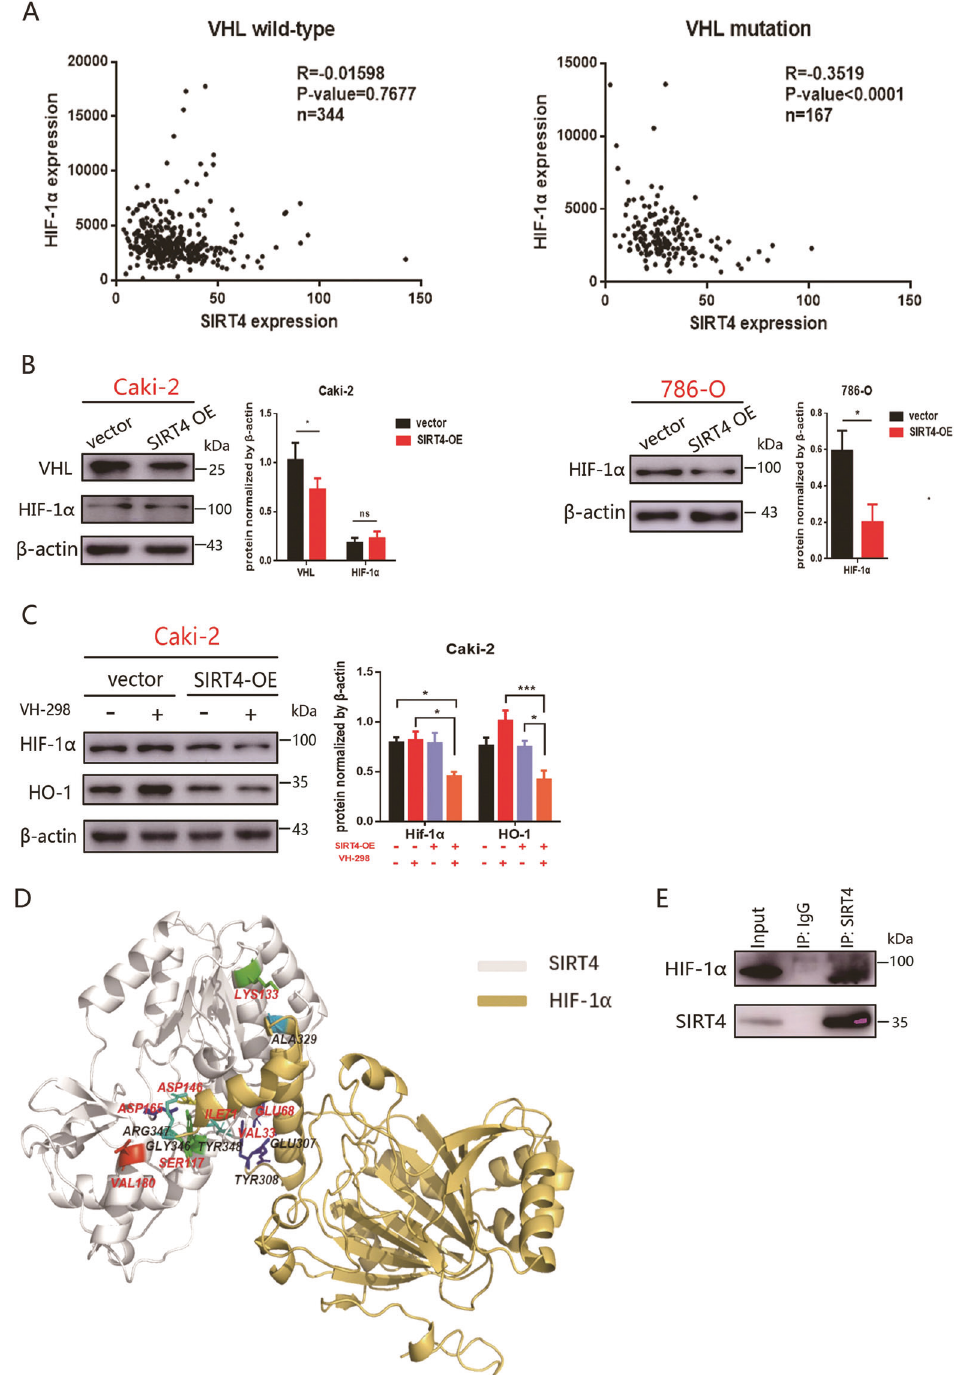
Fig. 6 SIRT4 interacts with HIF-1 α and directly suppresses the expression of HIF-1 α . A Analyzed the correlation between HIF-1 α and SIRT4 in mutated VHL and nonmutated VHL group from a TCGA cohort of ccRCC patients. B HIF-1 α protein in SIRT4 overexpressed 786-O and Caki-2 cells were displayed by western blot. The quanti fi cation analysis is shown on the right panel. C Caki-2 cells were treated with VHL inhibitor, VH-298 (50 µM), for 24 h followed by western blot. Densitometric analyses of HIF-1 α /HO-1 are shown on the right panel. D Molecular docking of SIRT4 and HIF-1 α was realized by zdock. E The immunoprecipitation was used to analysis the interaction of exogenous SIRT4 with endogenous HIF-1 α